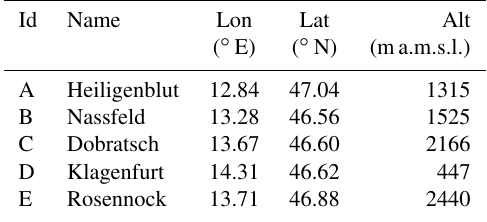
Table 1. Coordinates of the sample locations in Fig.